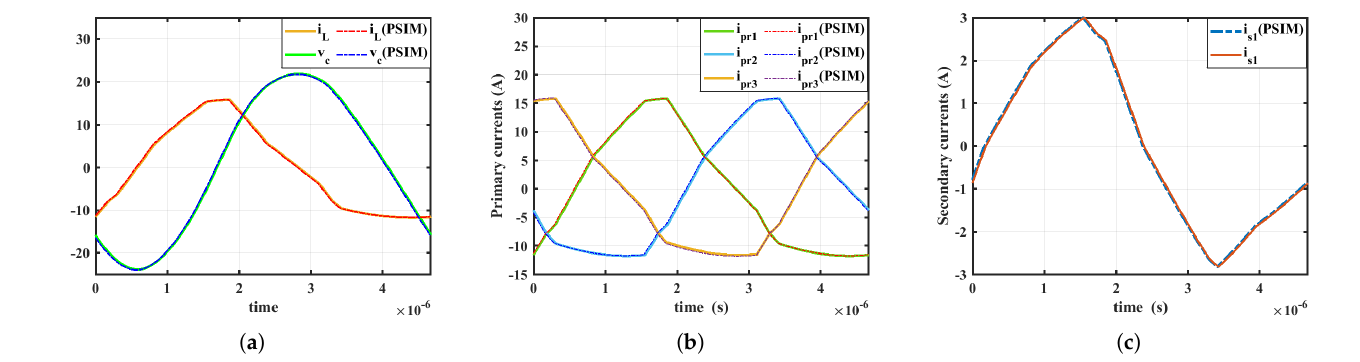
Figure 6. ( a ) Resonant current i L ( t ) and voltage across capacitor v c ( t ) ( b ) Currents in primary wind- ings i pr 1 , i pr 2 and i pr 3 ( c ) Secondary current i s 1 in CCM1 mode obtained from simulation and